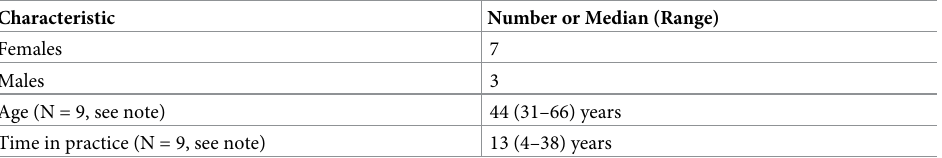
Table 1. Demographics of sample (N = 10).